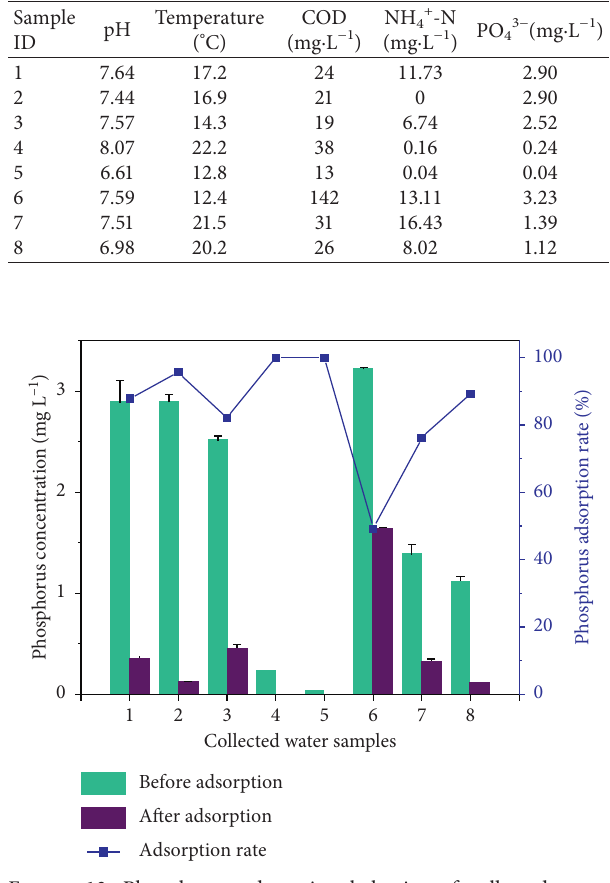
Figure 13: Phosphorus adsorption behavior of collected water samples (equilibrium: t � 10min, adsorbent dosage � 2 g · L − 1 , 120rpm, and 25 °